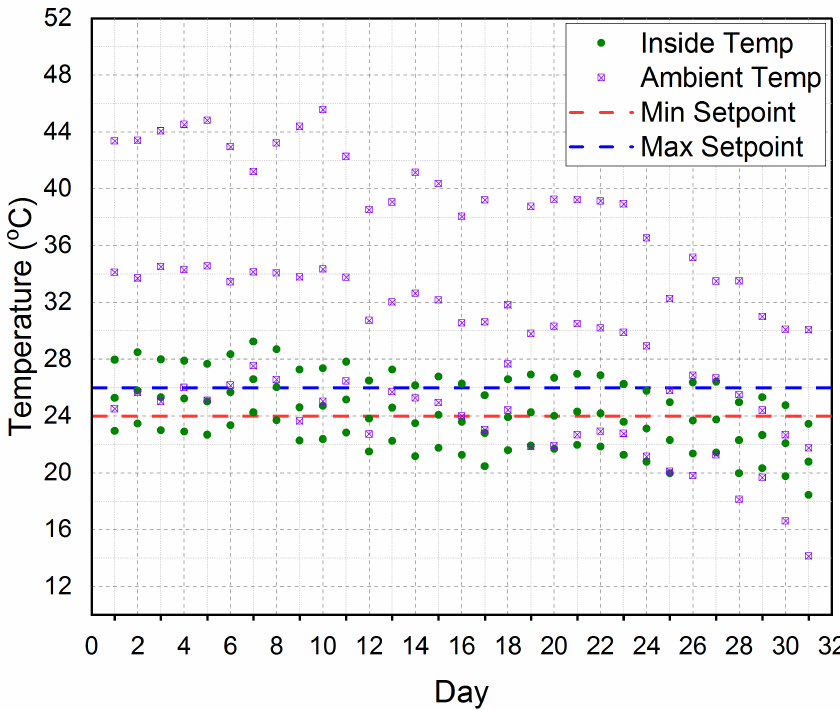
Figure 9. The three months average for inner greenhouse temperature (Inside Temp) and outside temperature (Ambient Temp) according to the minimum setpoint (Min Setpoint) and maximum setpoint (Max Setpoint) considered in our